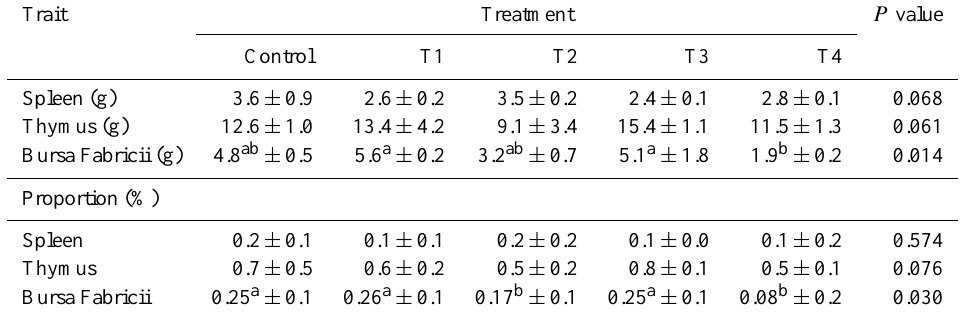
Table 4. Mean ( ± SEM) of weight of organs related to the immune response of broilers and the proportion of total weight that they make up.